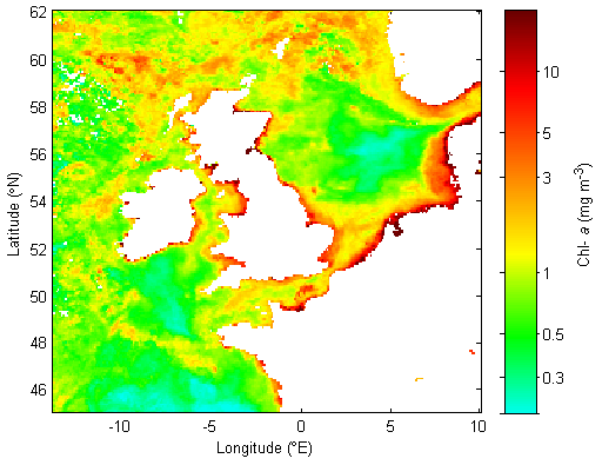
Figure 3. Aqua MODIS monthly composite image of sea surface temperature (SST) across the study area in June 2011. SST at 4.63km resolution is determined from mid-infrared radiation mea- sured during night-time passes.